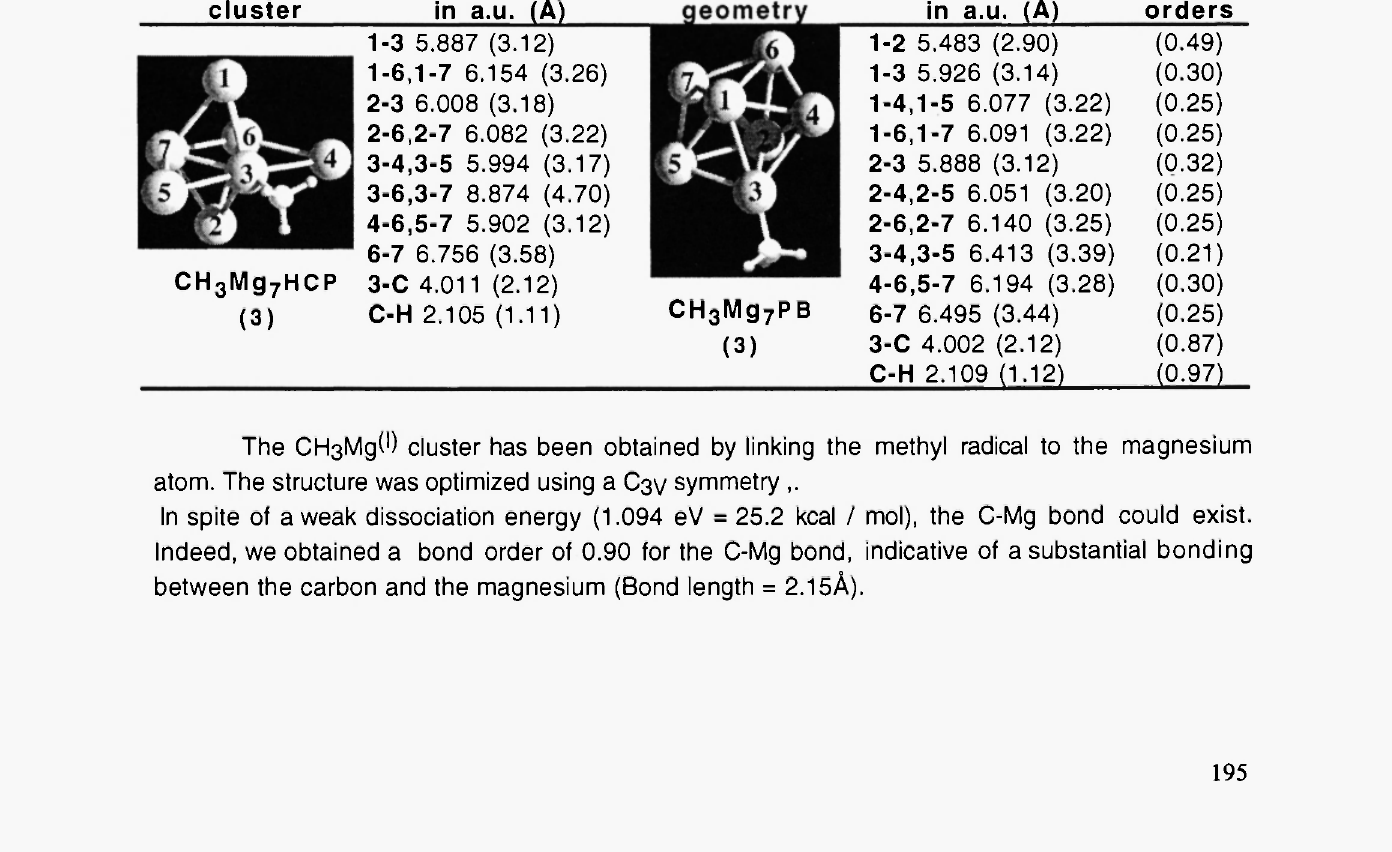
Figure 5 : Evolution of the unstable CH 3 Mg 7 PB(3)